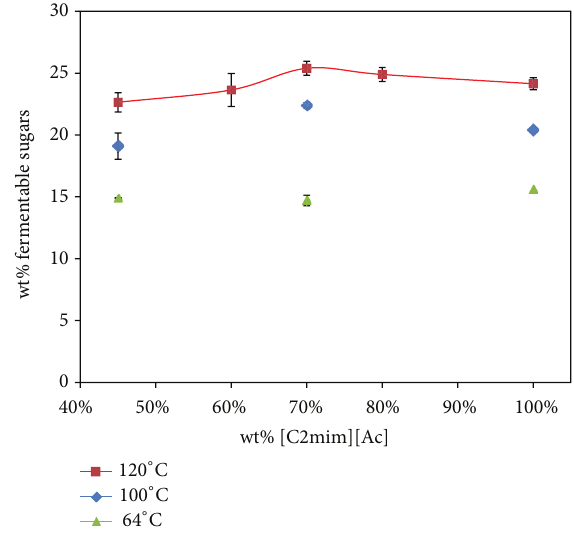
Figure 1: Total fermentable sugar yields relative to weight of whole seed from enzyme hydrolysis of safflower whole seed pretreated at various temperatures.